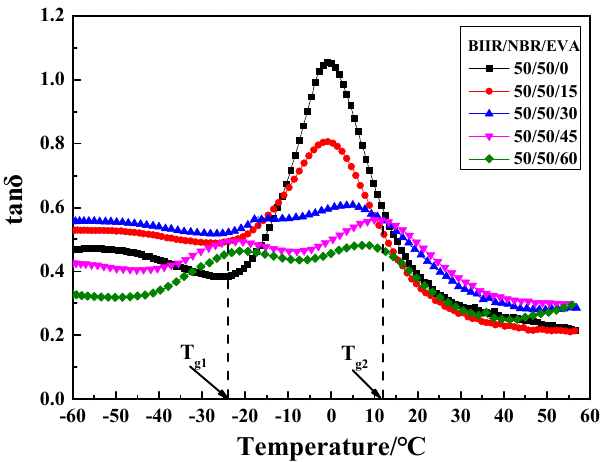
Figure 14. Damping properties versus temperature for NBR/BIIR/EVA with various blend ratios. Table 6. Damping property parameters of NBR / BIIR / EVA with various blend